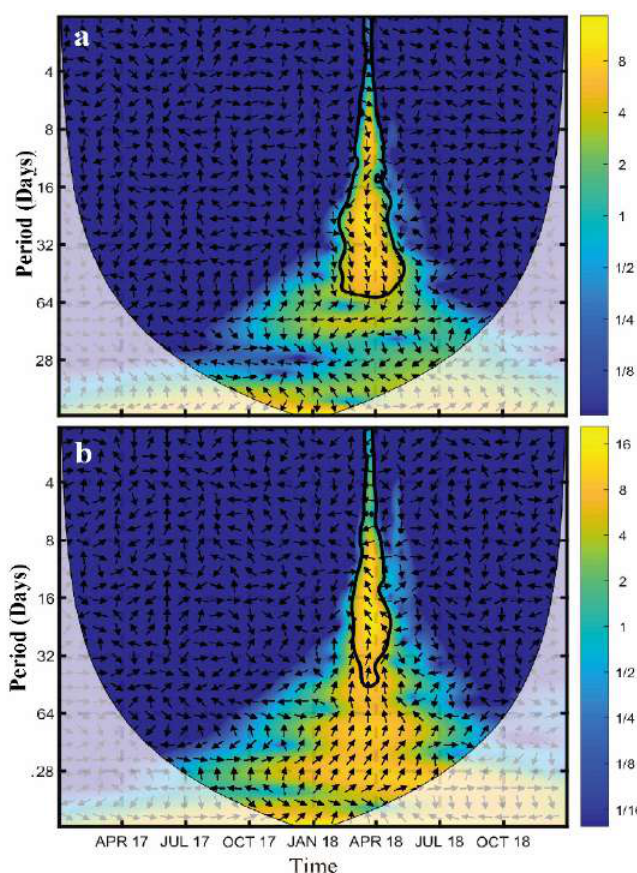
Fig. 9: Wavelet cross transformations in the study area where the thick black contours show a 95% confidence level for: (a) ACE and SST, (b) ACE and Chl-a. The wavelet calculation and visualization were carried out using MatLab